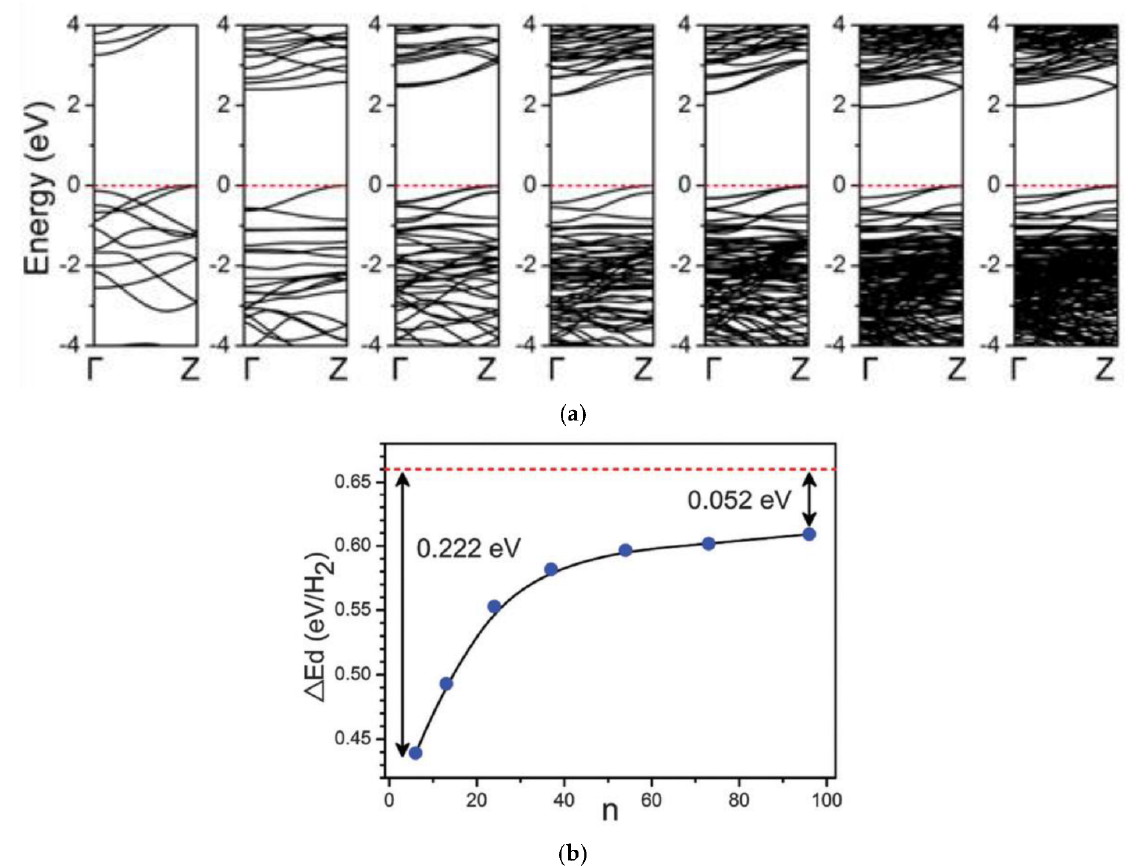
Figure 42. ( a ) Band structures of MgH 2 ( n , D ) nanowires, from left to right: MgH 2 (6, 0.63), MgH 2 (13, 0.87), MgH 2 (24, 1.25), MgH 2 (37, 1.56), MgH 2 (54, 1.94), MgH 2 (73, 2.25), MgH 2 (96, 2.63) nanowire. The Fermi level is set to zero by the red horizontal line. n is the number of Mg atoms in the supercells and D is the calculated diameter in nm. ( b ) Hydrogen desorption energy ∆ E d (eV per H 2 ) of MgH 2 nanowires. Red dashed lines represent the hydrogen desorption energy of the bulk MgH 2 crystal. ( a , b ) Reproduced with permission [201]. Copyright 2016, ROYAL SOCIETY OF CHEMISTRY.